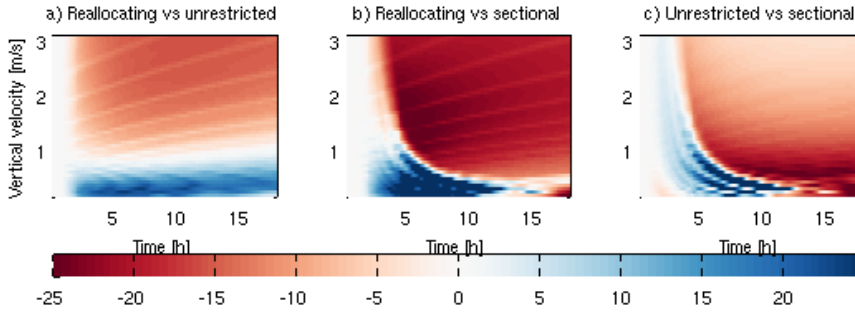
Fig. 7. Relative difference of the cloud–aerosol interaction parameter between the three models. Figure 7: Relative difference of the cloud-aerosol interaction parameter between the three models.